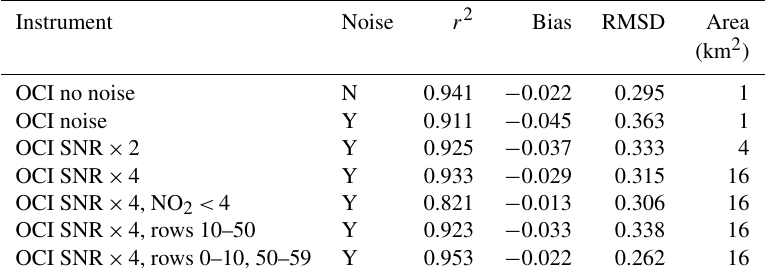
∗ Data from 15 June 2005 withheld from training and used as evaluation (16286 samples). Table 3. Statistics computed on 28 January 2005 (day not used in training) for simulated PACE OCI SCD normalized by stratospheric air mass factor with the SNR model from Fig. 1b. Statistics include the root-mean-square difference (RMSD), bias, and variance explained ( r 2 ) of the normalized SCD (normalized by the stratospheric air mass factor). The bias, RMSD, and thresholds are given in units of 10 15 molec.cm − 2 . The number of samples was 1113061 except for the experiment labeled NO 2 < 4 that used 831815